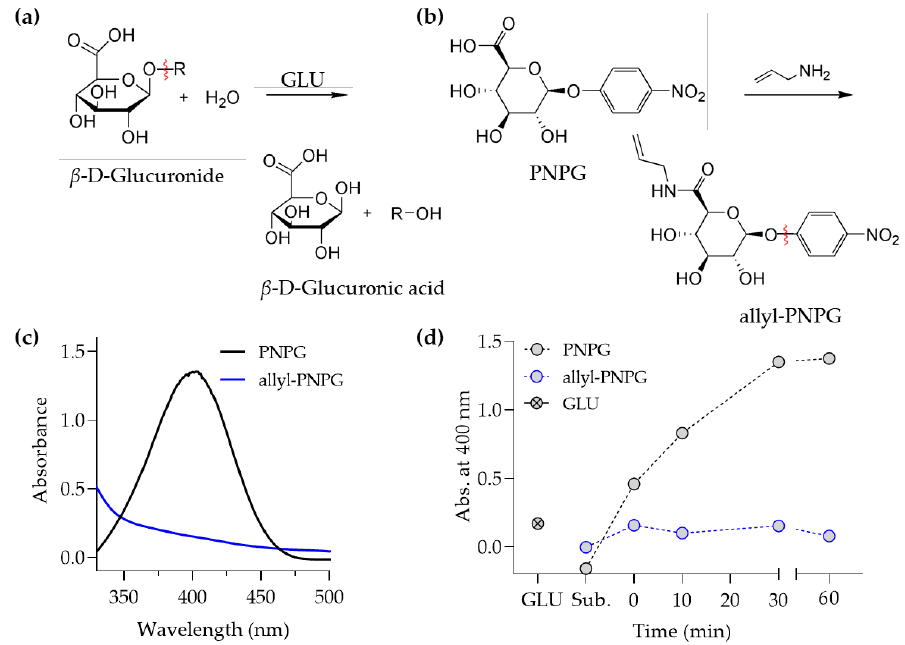
Figure 3. Synthesis of the allyl-substituted GLU substrate and its biodegradability. ( a ) GLU, a member of the glycosidase family, catalyzes the cleavage of a glycosidic bond at the non-reducing end and releases β- D - glucuronic acid from polysaccharides. ( b ) A modification of a carboxylic acid of PNPG with allylamine to tether the polymerizable allyl group. ( c ) UV–Vis spectra of PNPG and PNPG tethered with the allyl group (allyl-PNPG) after mixing with GLU for 30 min. PNPG displayed the characteristic spectrum of p -nitrophenol. ( d ) The absorbance was measured at 400 nm for PNPG and allyl-PNPG mixed with GLU over a varying incubation time.